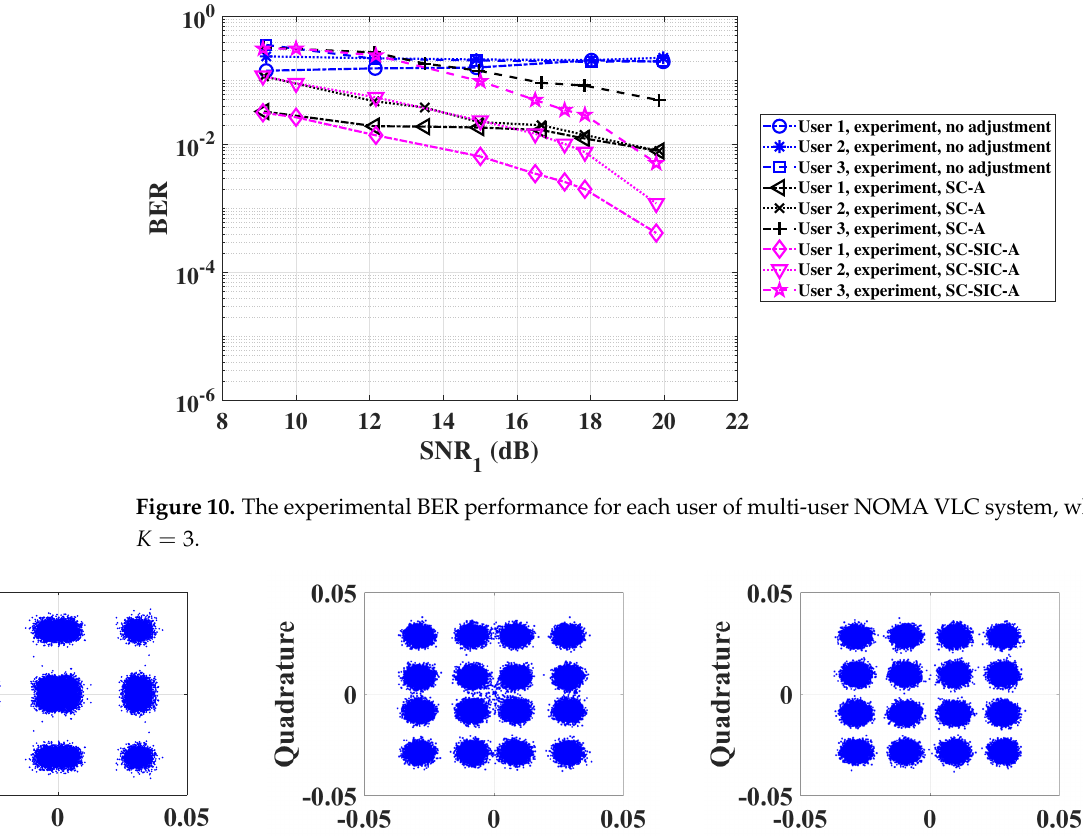
Figure 9. The experimental BER performance for each user of multi-user NOMA VLC system, when K = 2.